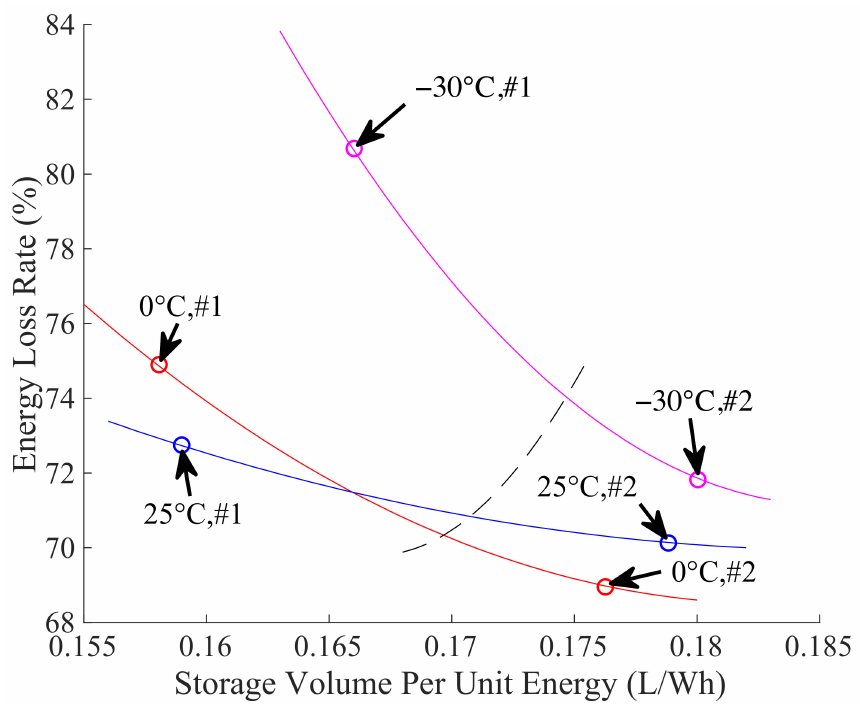
Figure 20. Pareto optimal solutions at different